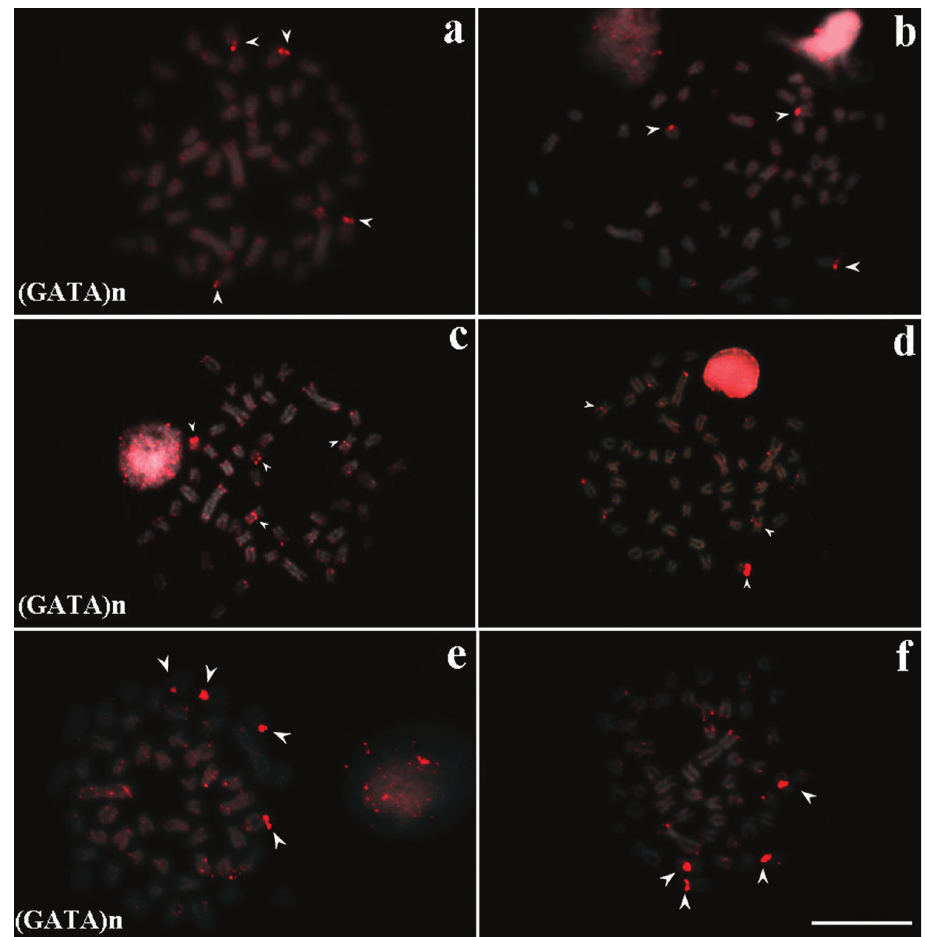
Figure 2. Fluorescence in situ Hybridization in metaphases of the three Astyanax scabripinnis populations ( a , b Lavrinha Farm Stream – LSF); ( c , d Lake of Pedalinho – LP); ( e , f Ribeirão das Perdizes – RP) with (GATA)n probe. a , c , e males and b , d , f females. Scales bar: 10 μm The male specimens from the (RP) population showed the pair of subtelocentric chromosomes 15 and 16 as their main signal (Fig. 2e), whereas the (GATA) on females is in the pair 2 m in proximal region and in the pair 20 a in terminal region (Fig. 2f) – heterochromatin places are associated with the probe in both sexes. The (GATA) probe did not evidence signal in the B chromosomes (Fig. 2a). n